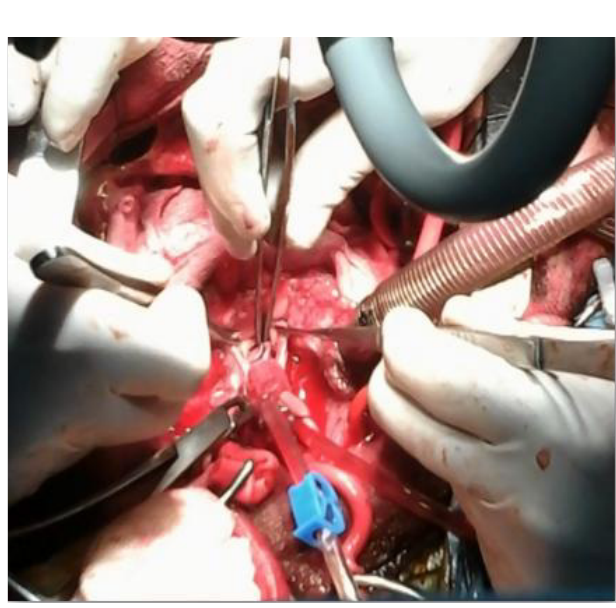
Fig. 3 - Final view of the new pericardial valve sutured to the fibrous annulus of the root. Good coaptation of the pericardial leaflets is